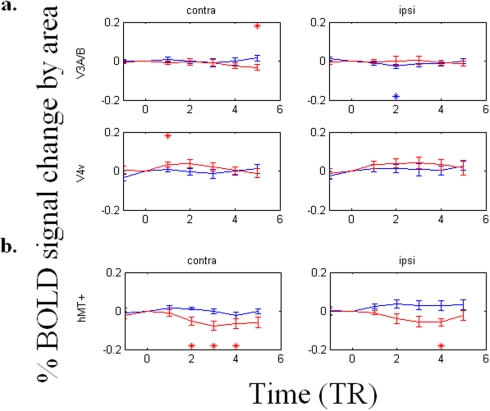
The differences of BOLD signal timecourses (TR = 1.6 seconds) upon perceptual switches in V3A/B, V4v, and hMT+.(a) The BOLD signal modulates weakly in V3A/B or V4v. (b) The BOLD signal modulates with the percept in contralateral hMT+, in a manner largely opposite that of V1v and V2v. In particular, BOLD signal decreases upon subjective disappearance of the dot in hMT+, but increases in V1 and V2.